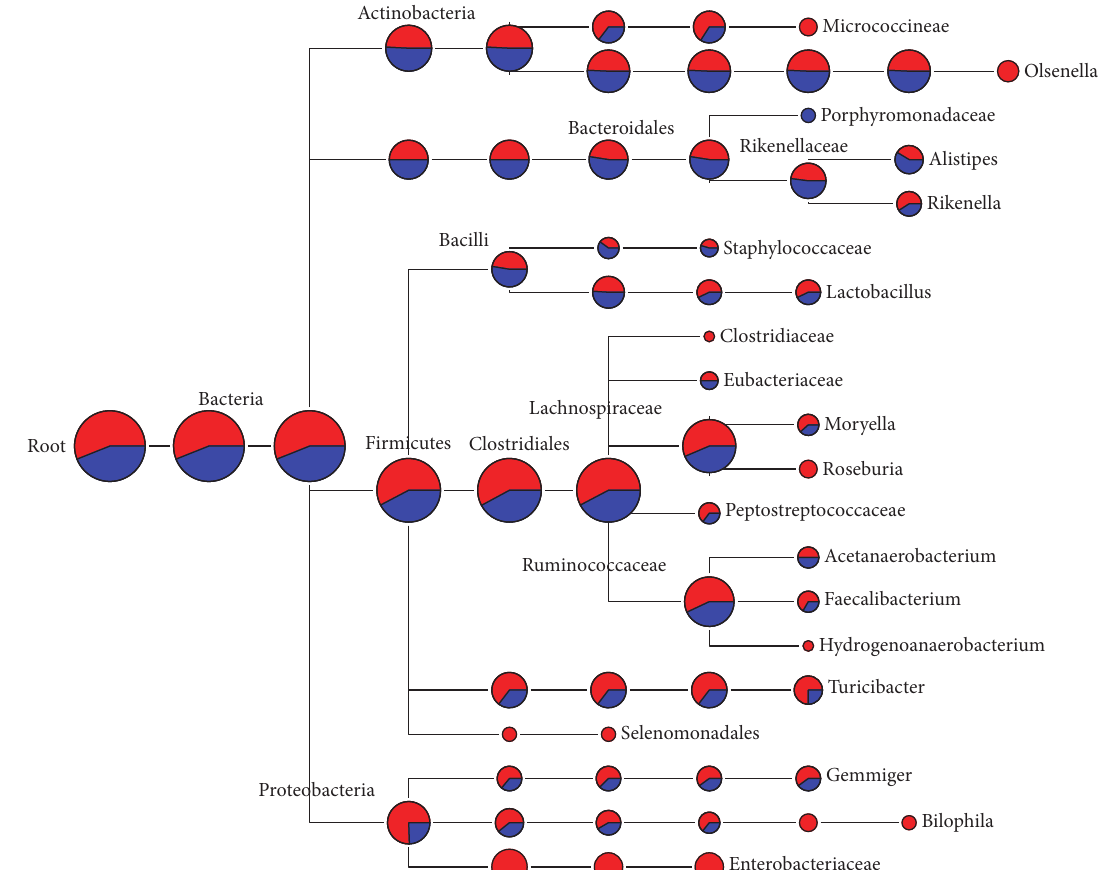
Figure 3: Bacterial diversity of turkey cecal content bacteriome. Only the genera represented by ≥ 5 OTUs each were shown, and the size of each node reflects the total number of OTUs. The relative proportion of taxa from the two pyrosequencing runs was shown by different colors: red, from the first run; blue, from the second